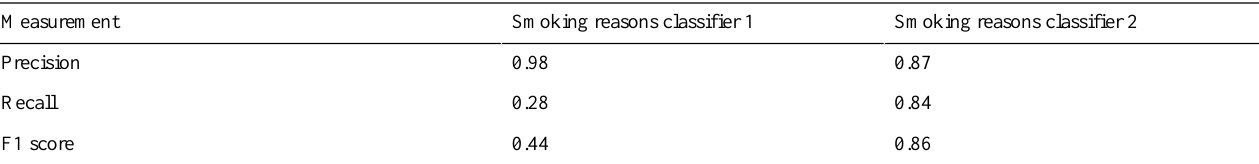
Table 4. Precision, recall, and F1 score for the smoking reasons classifier 1 and smoking reasons classifier 2 natural language understanding